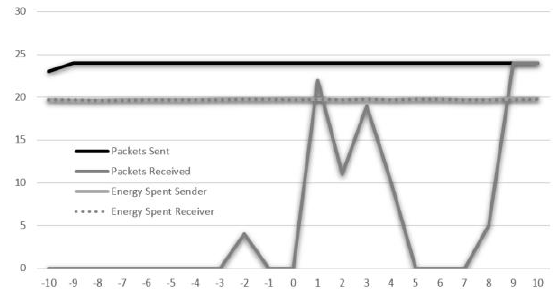
Figure 15. Remaining Energy vs Transmission Power under Scenario 2c for Nodes 3 and Node